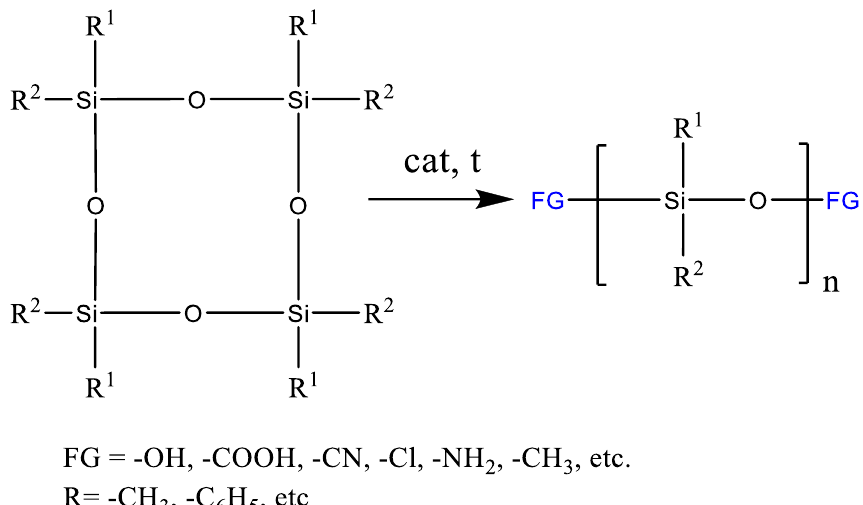
Figure 1. General scheme for the production of polyorganosiloxanes by the ROP mechanism.